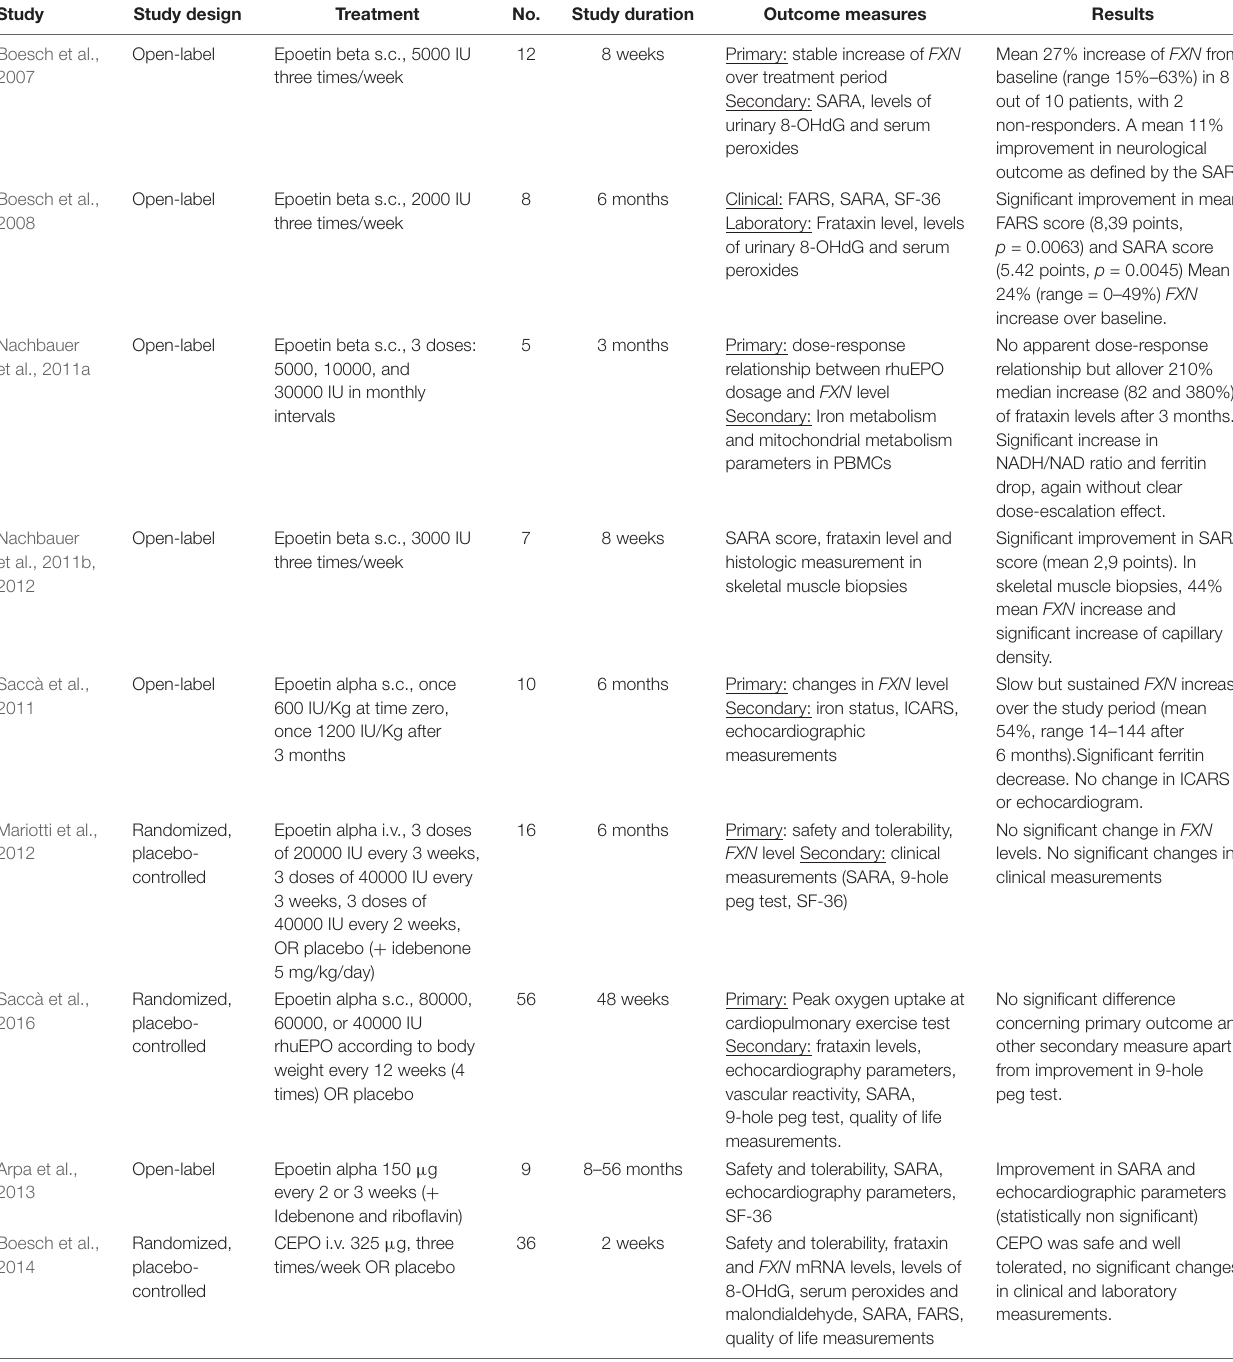
TABLE 1 | Overview of the published clinical studies on EPO and derivatives in